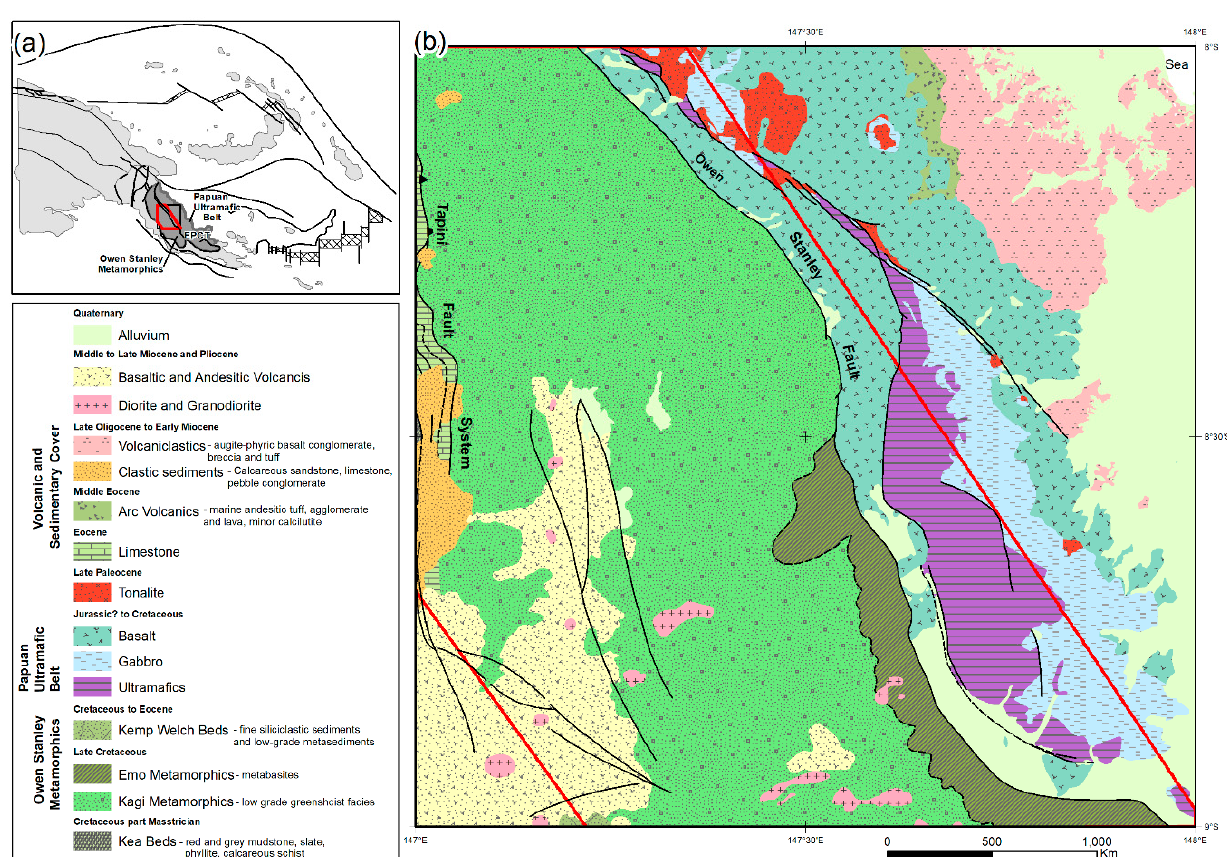
Figure 2. Location and simplified geological maps of the area of interest: ( a ) location of area of interest with respect to the EPCT geological terrane and surrounding terranes of Papua New Guinea. Modified from Williamson and Hancock (2005); ( b ) simplified geological map of the area of interest displaying dominant rock units and faults in the area. Modified from Davies and Williamson (2012). Red polygon shows approximate extent of the airborne geophysics data for Figures 3 and 4.